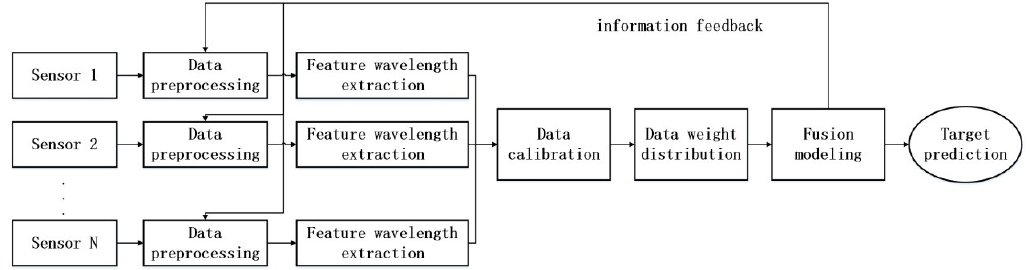
Figure 7. Process of using multi-source data fusion to detect water quality parameters.